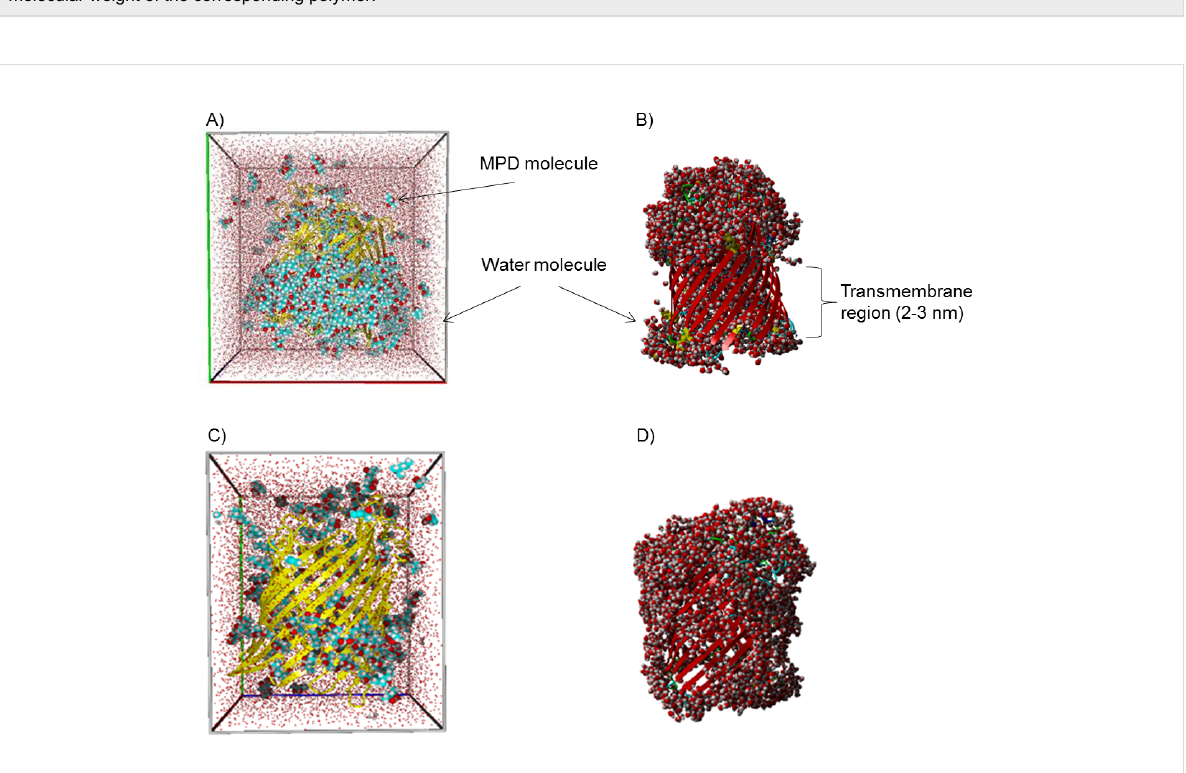
Figure 2: Hydrophobic transmembrane region of FhuA Δ CVF tev [29] stabilized by ≈ 200 MPD molecules. MPD is illustrated as mainly cyan molecules, water molecules are mainly red. A) A belt of 209 MPD molecules is located close to the transmembrane area. FhuA Δ CVF tev with 22,374 water and 378 MPD molecules was used as starting condition, in which most MPD molecules diffused away. B) Water molecules in the first solvation sphere (<5 Å) of FhuA Δ CVF tev are shown to visualize that the transmembrane area of FhuA Δ CVF tev is completely water free in MD simulations using 378 MPD molecules. C) MD simulations of FhuA Δ CVF tev with 12,208 water and 126 MPD molecules show that a saturation of the transmembrane region could not be achieved, leading to an incomplete coverage of the hydrophobic belt. D) Water molecules in the first solvation sphere (<5 Å) are partly covering the hydrophobic belt of FhuA Δ CVF tev using 126 MPD molecules. MPD,